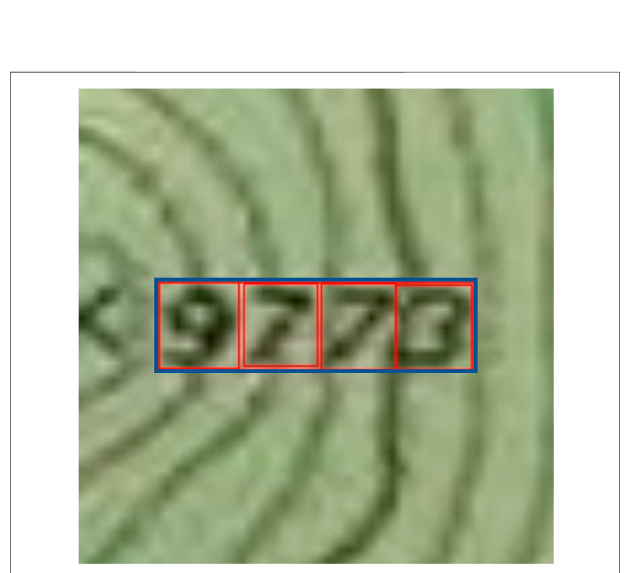
FIGURE 4 | A training image of the HTMC showing bounding boxes for the spot elevation 9773 . The blue box is the outer bounding area, and each redboxdelimitsasingledigit.Boundingboxesarerepresentedtothemachine via text labels rather than displayed on the image as seen here.